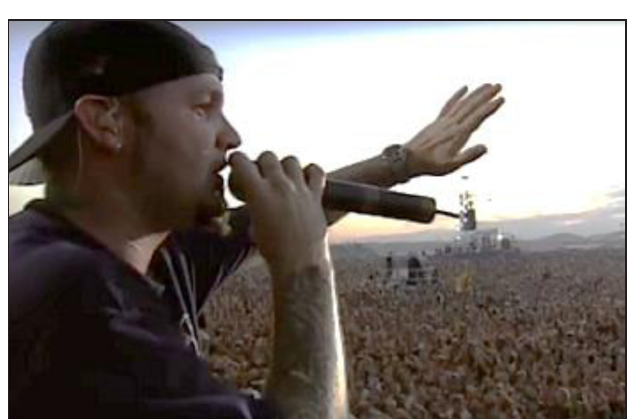
Figure 1: Fred Durst addresses Woodstock, July 24, 1999 (official Limp Bizkit on Music